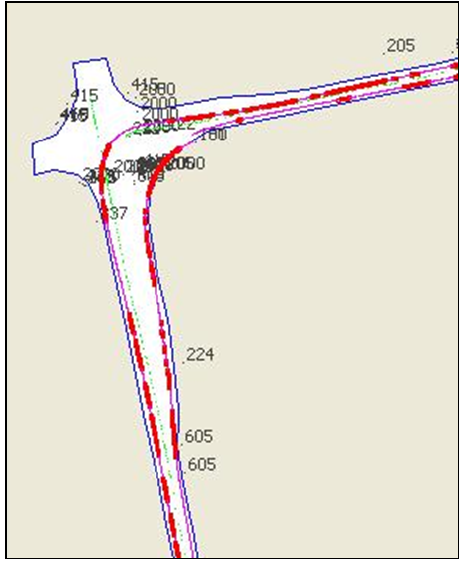
Figure 4: Plotting of GPS positions in